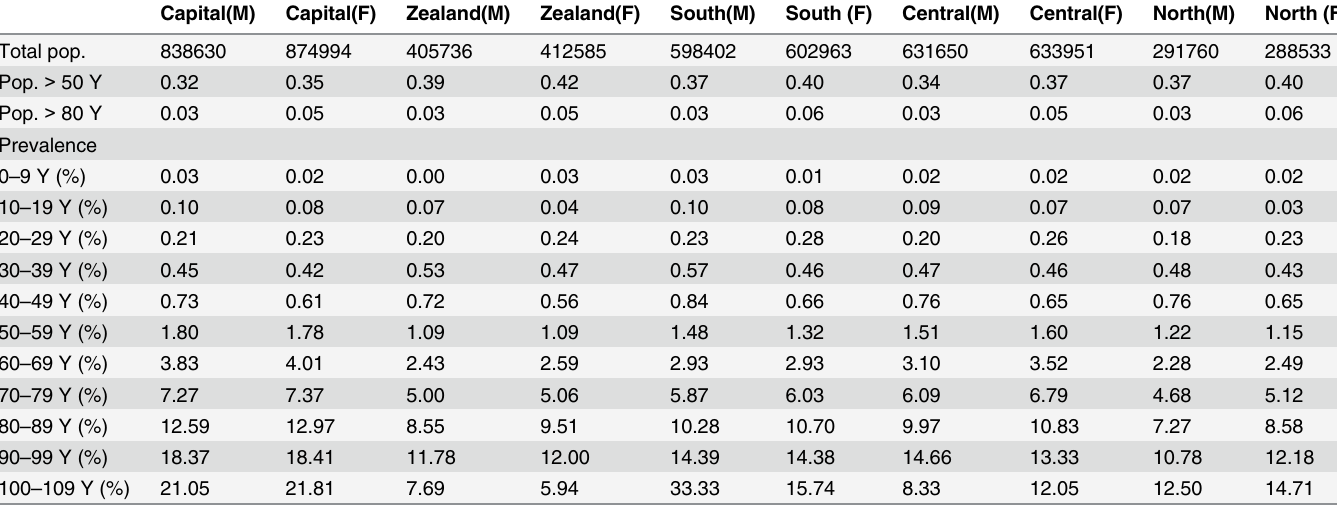
Abbreviations: Capital = The Capital Region of Denmark; Zealand, Region of Zealand; South = Region of Southern Denmark; Central = Region of Central Jutland; North = The North Denmark Region; M = Male; F = Female; pop = population; Y =